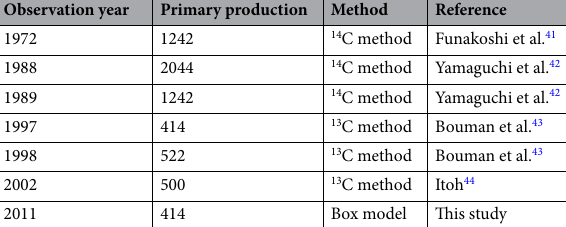
Table 1. Primary production in Tokyo Bay (gC m −2 year −1